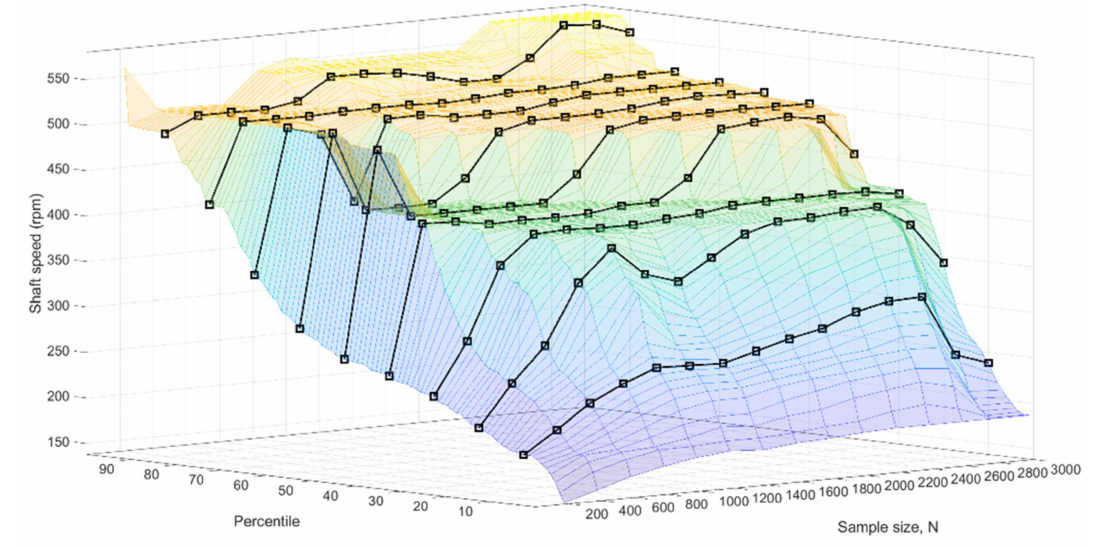
Figure 5. Illustration of 1st to 99th percentiles of shaft speed values. The deciles from first to ninth are marked by using black lines with squares placed on chosen sample